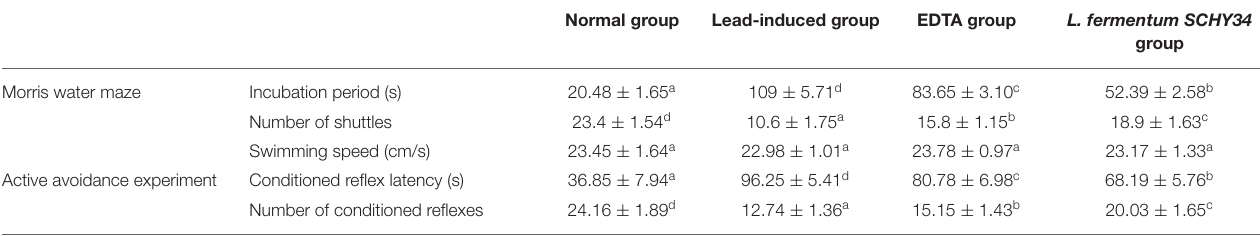
TABLE 3 | Rat behavioral tests.